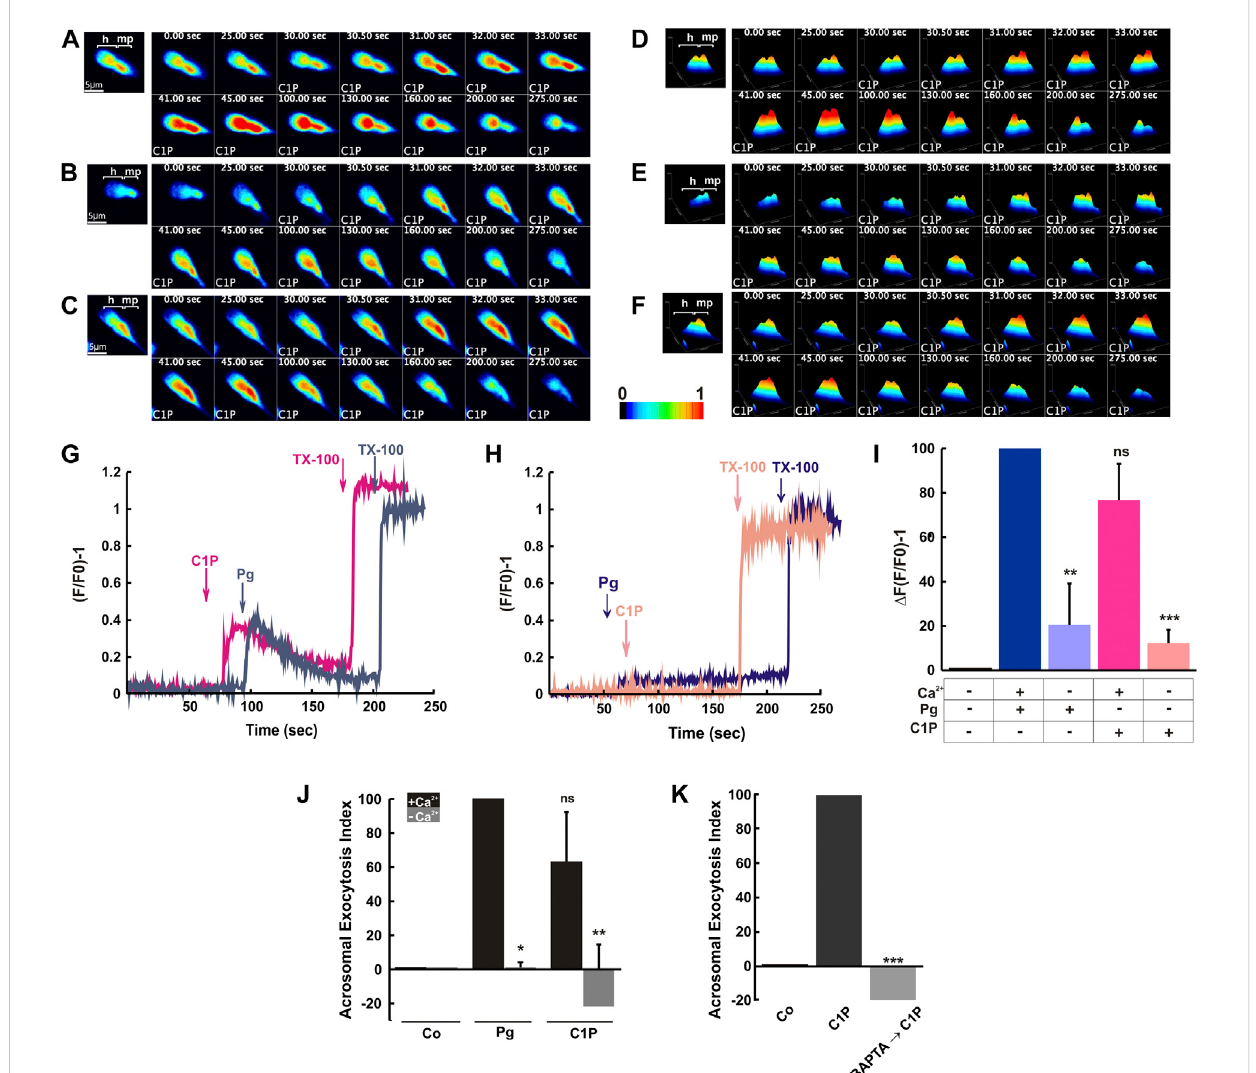
FIGURE 2 C1P-triggers extracellularcalciumin fl uxleadingto spermacrosomal exocytosis.Capacitatedhuman spermwereloadedwith Fluo-3 AM(2 μ M)and suspended in HTF medium containing a fi nal concentration of 2 mM CaCl 2 . The fl uorescence intensity was visualized before and after C1P addition as described under “ Materials and Methods ” . (A – C) Sequence of fl uorescence images from human sperm capacitated and loaded with Fluo-3AM showing changes in [Ca 2+ ]i before (0 s) and after (25, 30, 30.5, 31, 32, 33, 41, 45, 100, 130, 160, 200, and 275 s) the application of 10 μ M C1P. Shown are representative images of three individual human sperm. (D – F) Surface plots of the cells shown in panels A – C, also plots indicate the increase in fl uorescenceintensityinresponseto10 μ MC1P.Fluorescenceisexpressedas(F/F0) − 1 versus time.Pseudocolorfromblacktoredrepresentslowtohigh [Ca 2+ ]i, respectively. h: head, mp: midpiece. (G) Calcium sperm response to C1P in population. Human sperm were loaded with 2 μ M Fluo-3 AM for 30 min at 37 ° C. At the indicated times (arrows) 10 μ M C1P or 15 μ M progesterone (Pg) were added. Maximal [Ca 2+ ]i response was calibrated with 0.1% TritonX-100(TX-100)attheendoftheincubationperiod.Shownaretracesrepresentativeof6experiments.Theincreasein fl uorescenceisexpressedas (F/F0) − 1 ((maximum fl uorescence intensity/initial fl uorescence) - 1) versus time in seconds. (H) Capacitated male gametes were suspended in the same mediumincluding0.75 mMEGTAtochelatethecalciumleavingtheHTFwitha[Ca 2+ ] ≤ 100 nM.Then,cellswereloadedwith2 μ MFluo-3AMfor30 min at 37 ° C. At the indicated times (arrows), 10 μ M C1P or 15 μ M progesterone (Pg) were added. Maximal [Ca 2+ ]i response was calibrated with 0.1% Triton X- 100 (TX-100) at the end of the incubation period. (I) Summary of Figures 2G,H. The data represent the mean ± S.E. of fi ve experiments. (J) Acrosomal exocytosis was evaluated by FITC-PSA binding. We scored at least 300 cells per condition. Sperm batches incubated in normal calcium concentrations (black bars) and treated with 0.75 mM EGTA (gray bars) were challenged with 10 μ M C1P or 15 μ M progesterone (Pg). The data represent the mean ± S.E. of at least fi ve independent experiments. The means of groups + Ca 2+ and -Ca 2+ were compared to Pg treatment (2 mM Ca 2+ ) using Dunnett ’ s test and classi fi ed as non-signi fi cant (ns, p > 0.05) or signi fi cant (*, p ≤ 0.05; **, p ≤ 0.01). (K) Capacitated sperm were incubated with 5 mM BAPTA for 15 min and after that, C1P was added and further incubated for 15 min. Acrosomal exocytosis was evaluated by FITC-PSA binding scoring at least 300 cells per condition. The data represent the mean ± S.E. of four independent experiments. We used Dunnett ’ s test to compare the means of all groups against the Control condition and classi fi ed them as signi fi cant (***, p ≤